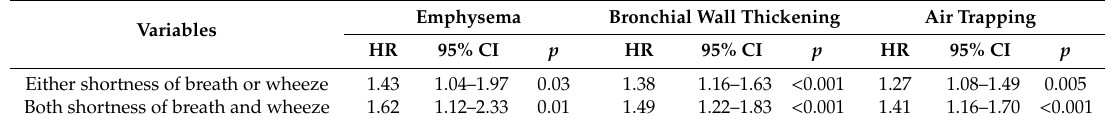
Table 4. Subpopulation with respiratory symptoms reported within six months of exposure a,b .